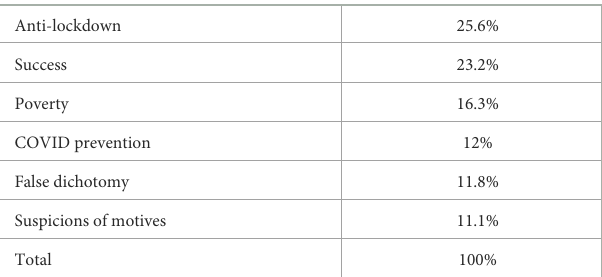
TABLE 2 The prevalence of tweets in each